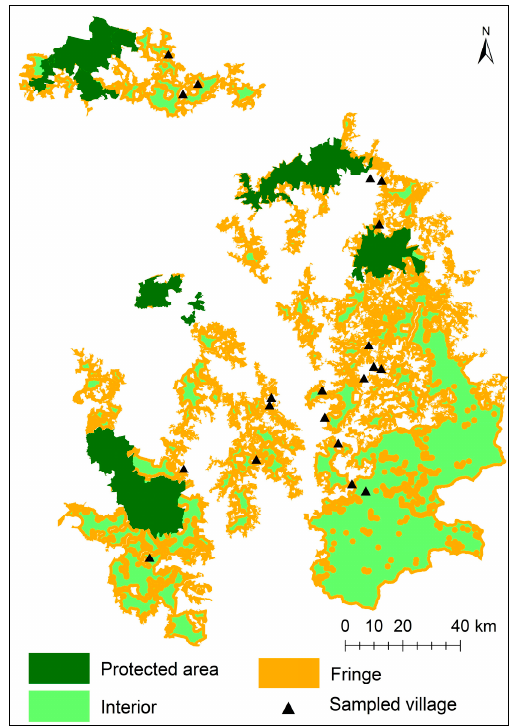
Figure 2. Distribution of interior and fringe forests in the landscape along with locations of selected villages.